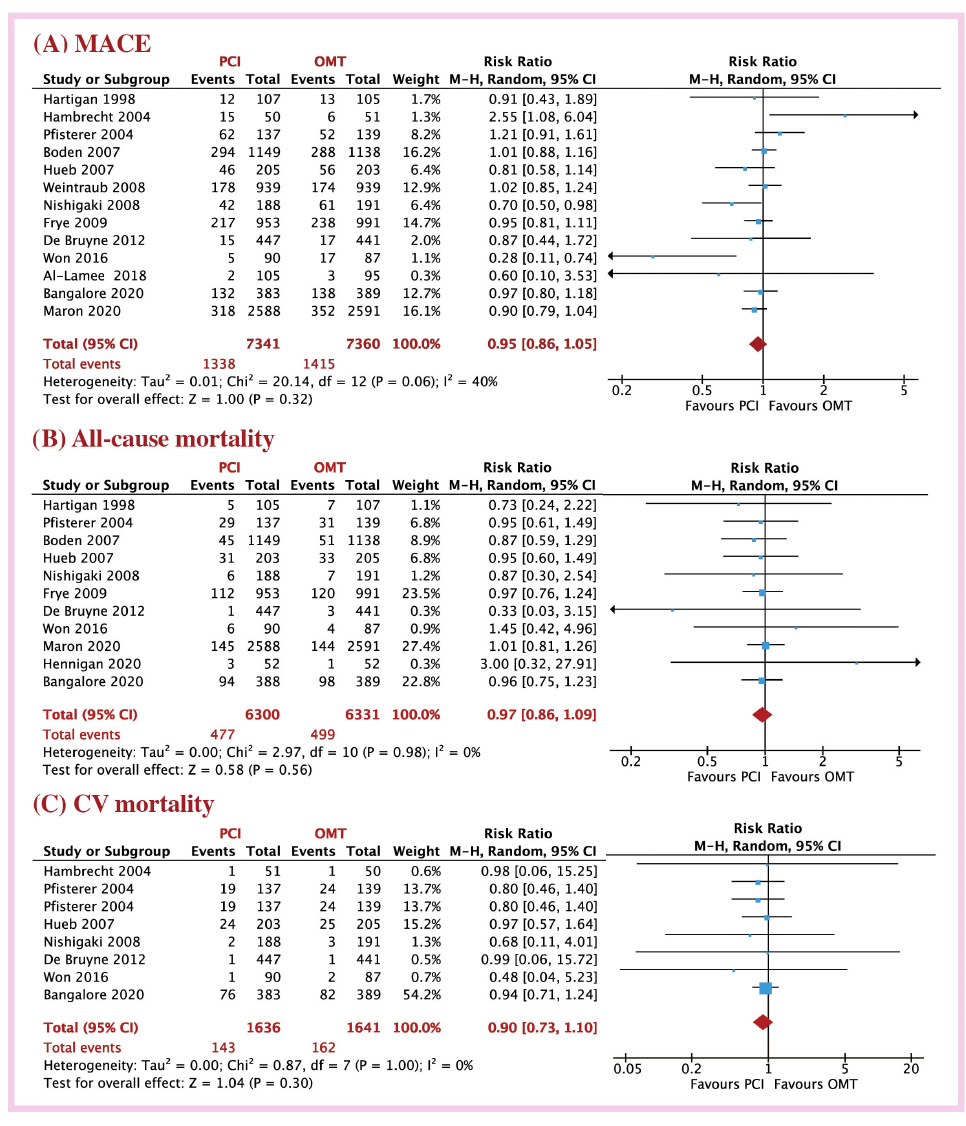
Figure 1. Risk ratio of outcome with PCI versus OMT in CCS patients; ( A ) MACE, ( B ) all-cause mortality, ( C ) CV mortality. Abbreviations: CCS: chronic coronary syndrome; PCI: percutaneous coronary intervention; OMT: optimal medical therapy; MACE: major adverse cardiac events; CV: cardiovascular.